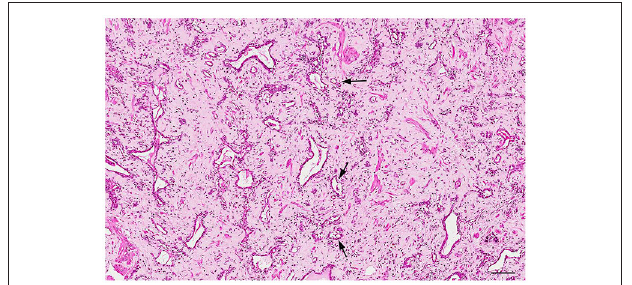
FIGURE 8 | Histology of the prostate from a castrated dog: hormonal atrophy with relative increase of the interstitial stroma and tubules lined by a single epithelial layer. Hematoxylin-eosin staining. Bar = 120 µ m.